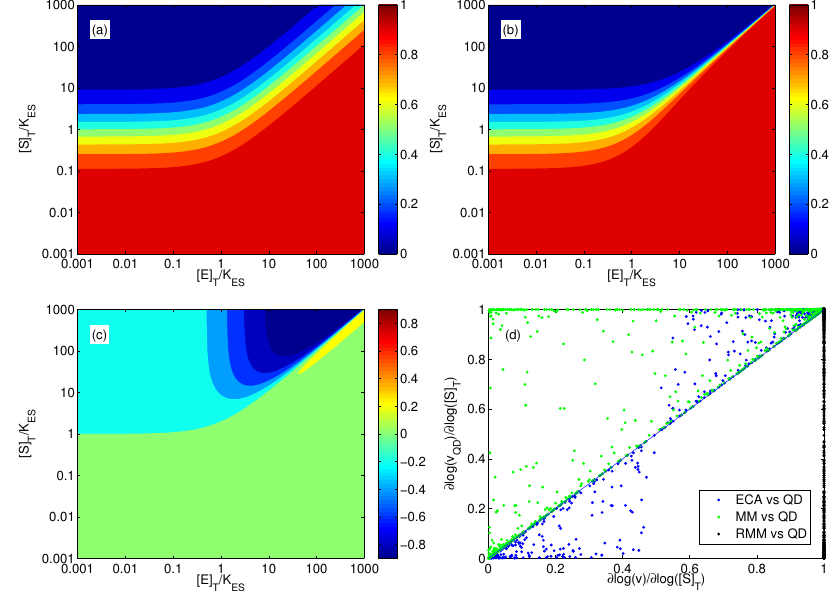
Figure 4. Similar to Fig. 1, but the sensitivity is evaluated against the total substrate concentration [ S ] T